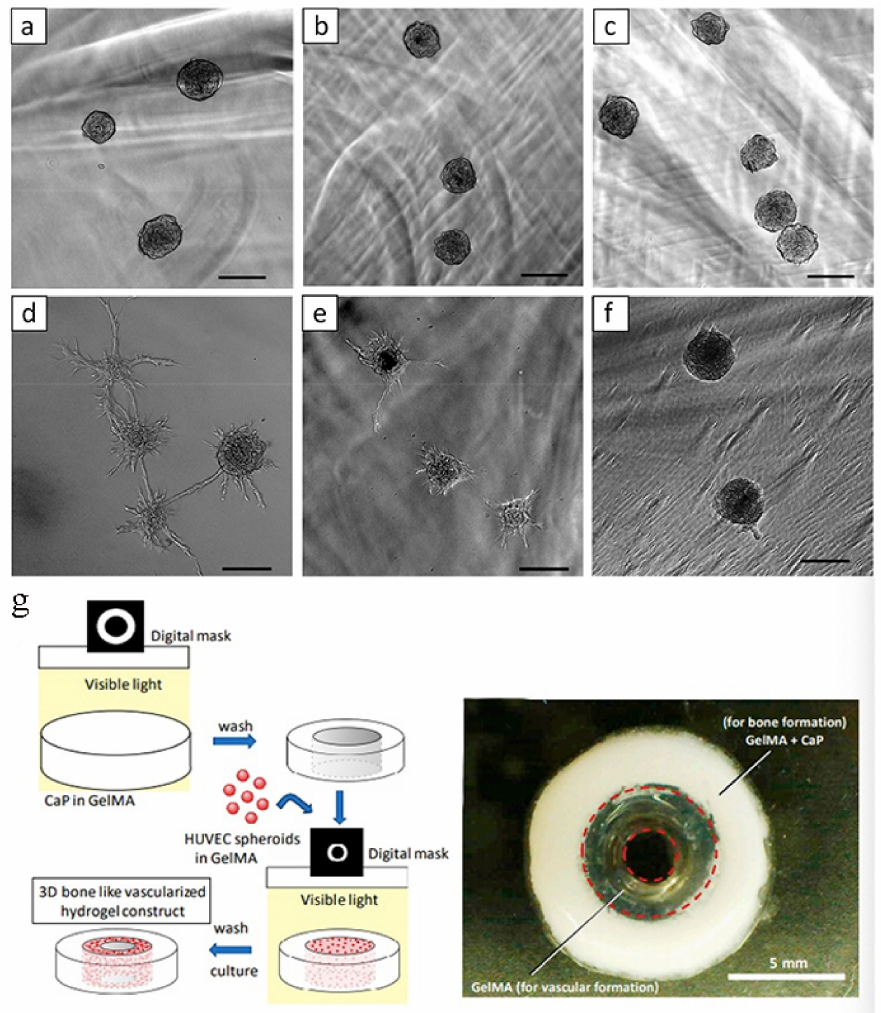
Figure 8. Three-dimensional in vitro angiogenesis of human umbilical vein epithelial cells (HUVEC) spheroids in the different concentrations of GelMA (( a , d ) 5%, ( b , e ) 7.5%, and ( c , f ) 10%) just after polymerization of GelMA ( a – c ), and after 1 day of culture ( d – f ). Bars = 100 µ m. ( g )